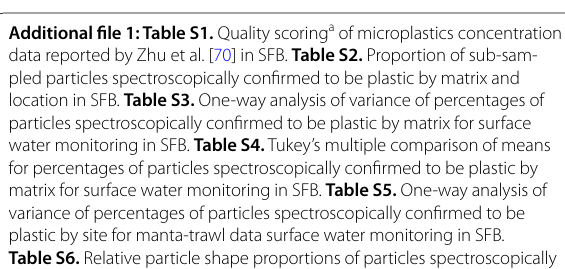
Figure S8. Cullen and Frey graphs of A) proportion of total particles spectroscopically determined to be plastic based on subsampling in Zhu et al. [70], and B) log(10)-transformed fiber correction factors of manta trawl data based on 9 manta trawl samples in which all fibers were counted (data from [27]). Data were bootstrapped 1000 times (shown in yellow). Choice of distributions was based on proximity of observation (blue dot)